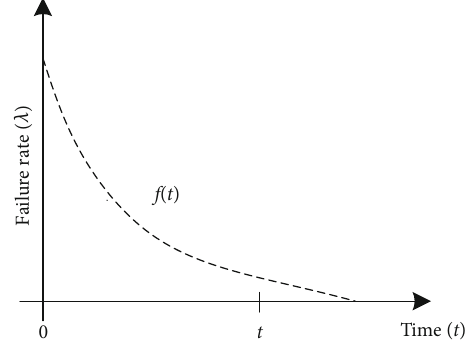
Figure 2: Density function f ð t Þ of a distribution e ð λ Þ .